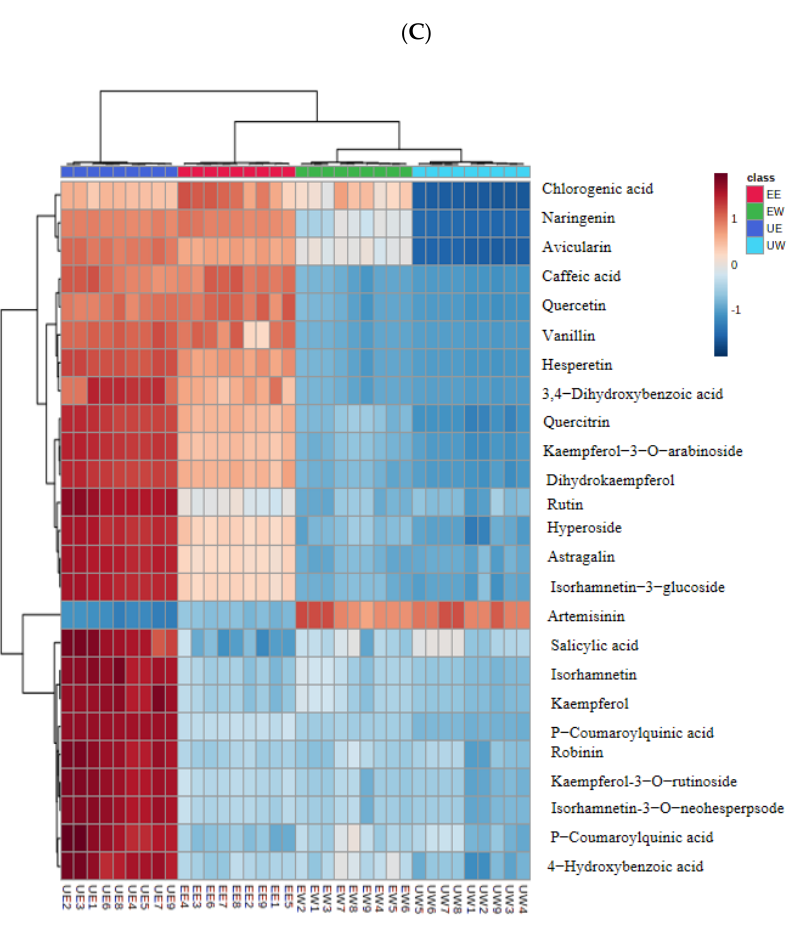
Figure 4. PLS-DA, VIP scores, and heat map of the four extracts in negative mode. ( A ) Scores plot of PLS-DA, ( B ) VIP scores, and ( C ) Heat map. Table 2. Contents of six differential compounds (mg/100 g DW) of the four daylily extracts.